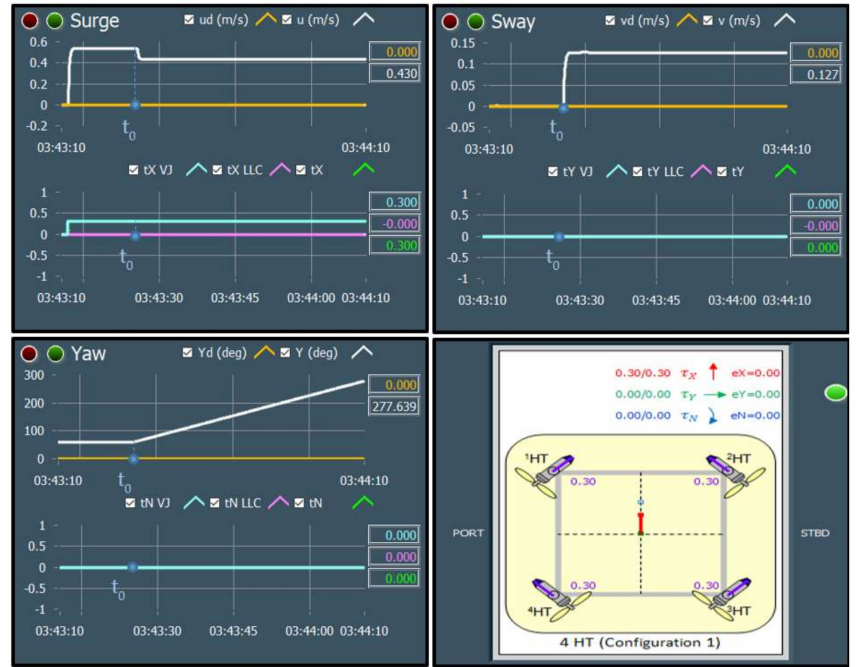
Figure 23. Test 1 (Open-Loop): Total fault in HT2 (“Broken Propeller”) occurred at t 0 ; the lack of fault accommodation causes the ROV to drift with continuous change in heading.